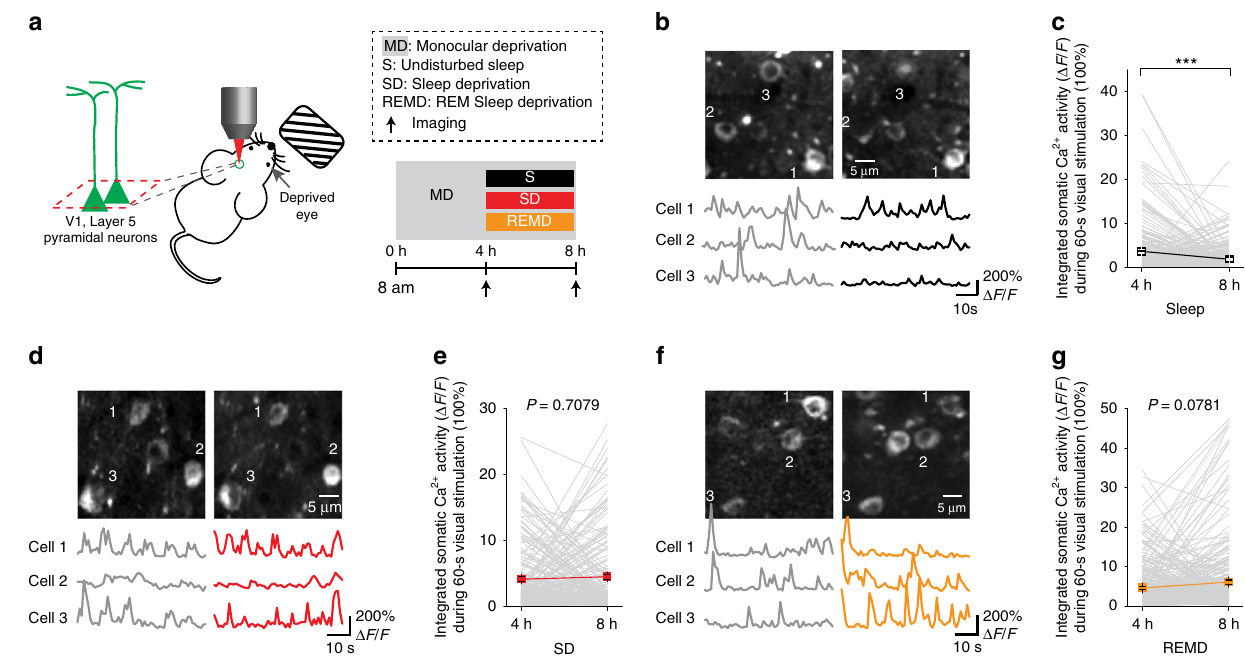
Fig. 2 SD or REMD prevents MD-induced neuronal activity reduction. a Schematic of experimental design. After the fi rst 4-h MD, mice were subjected to an additional 4-h MD and were either allowed to sleep or subjected to sleep/REM sleep deprivation. Two-photon Ca 2 + imaging was performed to assess the effect of sleep/REM sleep on somatic activity of layer 5 pyramidal neurons in V1. b Somatic Ca 2 + activity of layer 5 pyramidal neurons in the V1 contralateral to the deprived eye before (left) and after (right) 4-h sleep. Δ F / F 0 was summed to measure somatic Ca 2 + activity over 1 min. Scale bar: 5 μ m. 3 traces: somatic Ca 2 + activities of cells on the top. Ca 2 + fl uorescence traces over 60 s are shown. c The integrated somatic Ca 2 + activity during 60-s visual stimulation was signi fi cantly decreased after MD with 4-h undisturbed sleep ( n = 250 cells from 4 mice, P = 0.0002, Wilcoxon signed-rank test, two-sided). d Somatic Ca 2 + activity of layer 5 pyramidal neurons in the V1 contralateral to the deprived eye before (left) and after (right) 4-h SD. e 4-h SD signi fi cantly prevented the reduction of neuronal activity ( n = 194 cells from 4 mice, P = 0.7079, Wilcoxon signed-rank test, two-sided). f Somatic activity of layer 5 pyramidal neurons in the V1 contralateral to the deprived eye before (left) and after (right) 4-h REMD. g REMD for 4 h signi fi cantly prevented the reduction of neuronal activity ( n = 294 cells from 3 mice, P = 0.0781, Wilcoxon signed-rank test, two-sided). *** P < 0.001. Data are presented as mean ± s.e.m. Source data for ( c ), ( e ), and ( g ) are provided as a Source Data fi